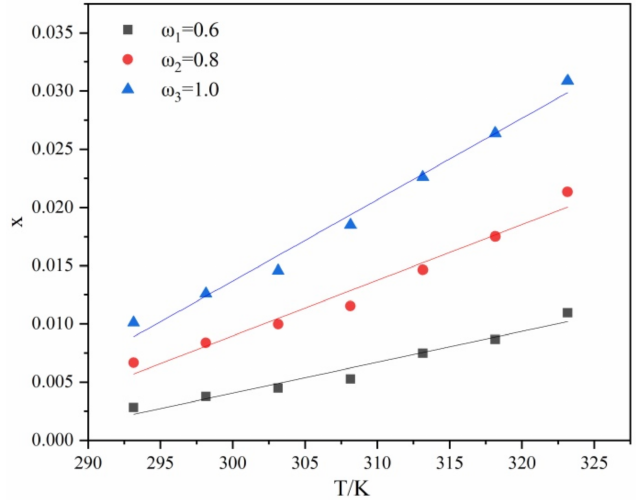
Figure 3. Relationship between solubility and temperature of PMBA under different ethanol mass fractions.